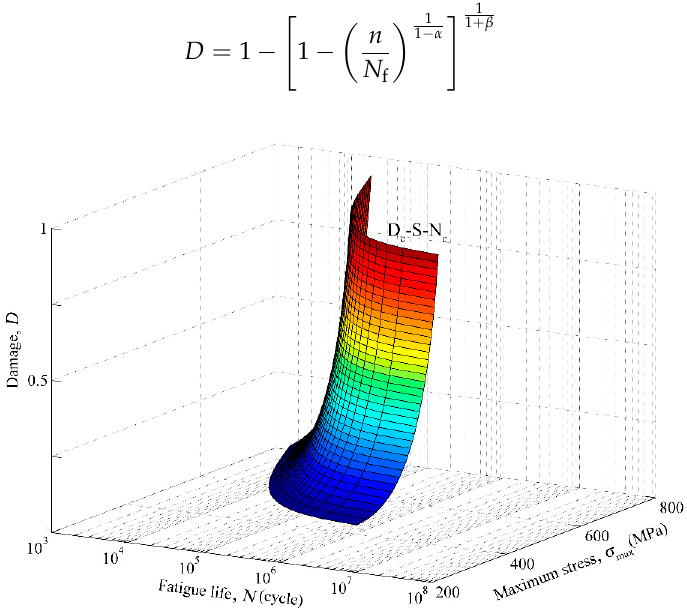
Figure 1. D–S–N surface defined by the Chaboche model.